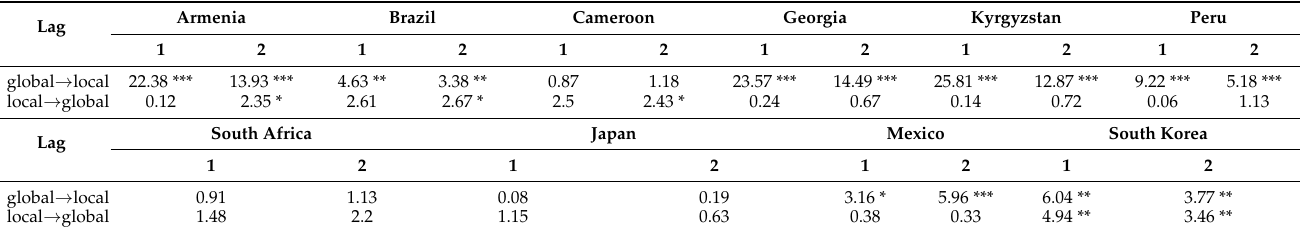
Table 4. Granger causality